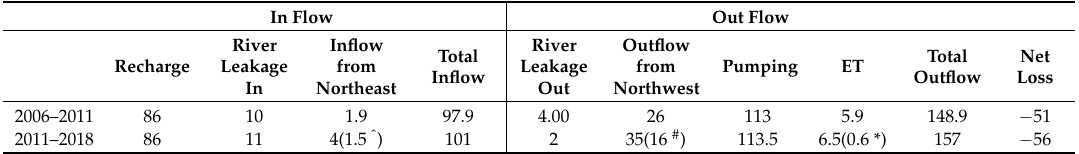
Table 1. Groundwater balance in million (mm 3 ) for the Muktsar district between 2006–2011 and 2011–2018.